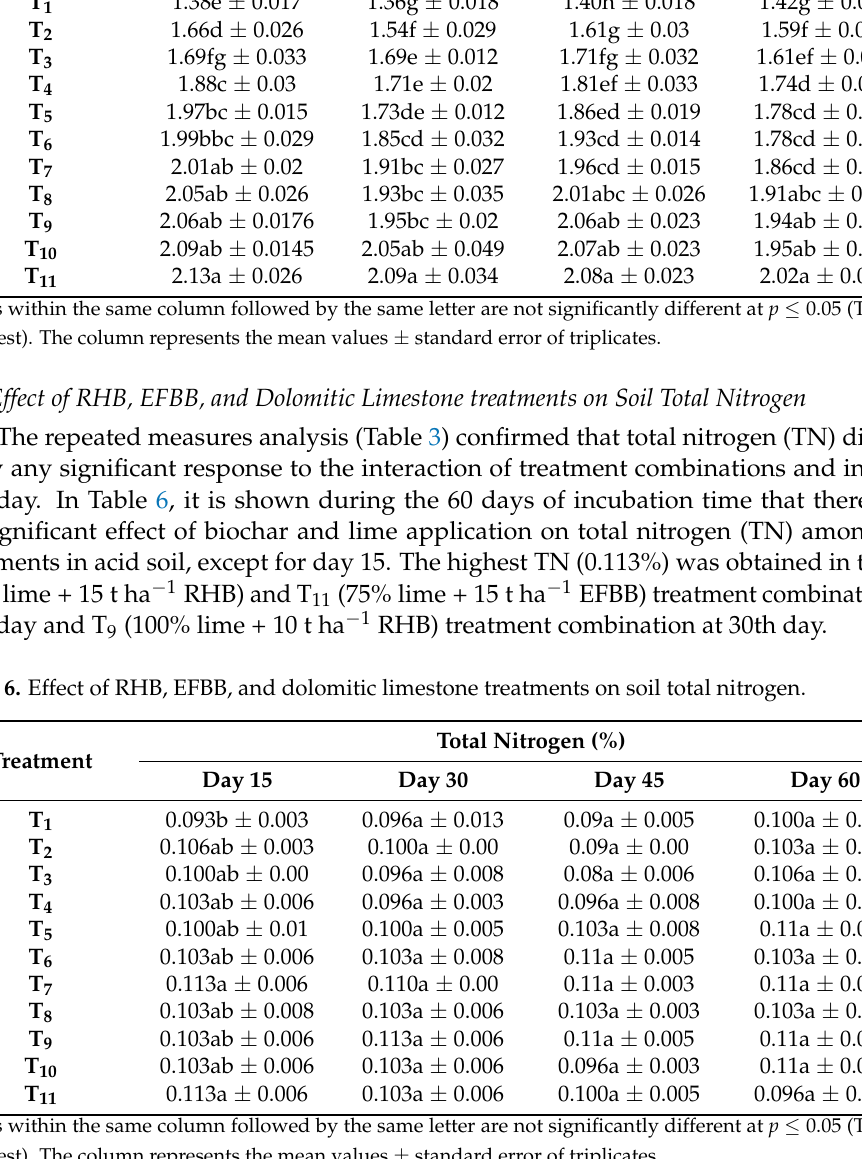
Table 5. Effect of RHB, EFBB, and dolomitic limestone treatments on soil total carbon. Treatment